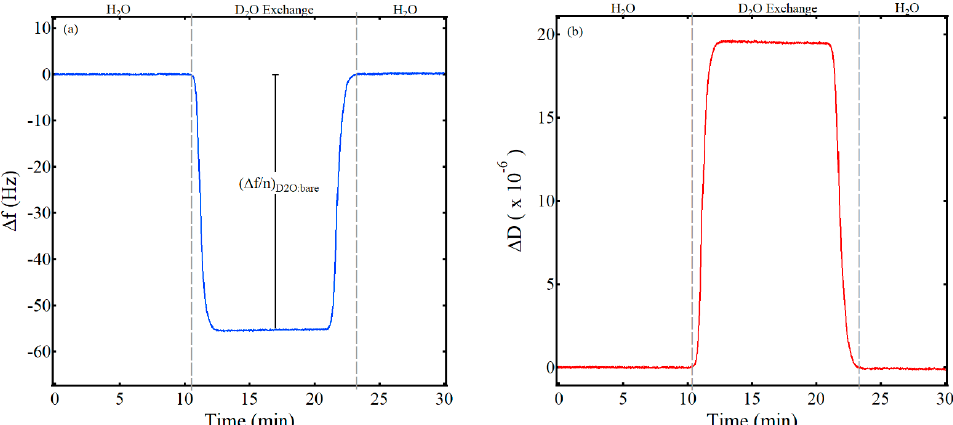
Figure 1. Frequency ( a ) and dissipation ( b ) values for a D 2 O exchange on a bare gold QCM sensor crystal. The vertical, gray, dashed lines highlight when the liquid was switched from water to D 2 O and back to water. The change in frequency for the deuterated solvent exchange of the bare crystal used to determine the thin film water content in Equation (3) is annotated as ( ∆ f/n) D2O:bare .